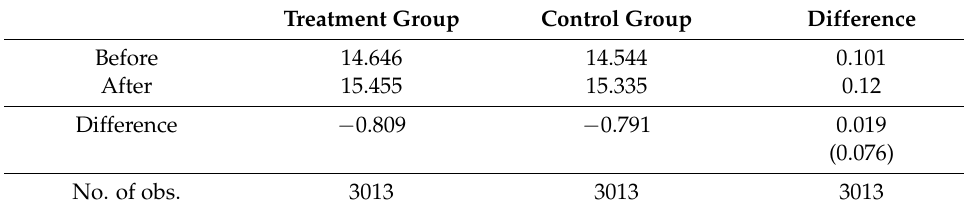
Table 4. The DID estimation of the impact of irrigation on log rice farm income. Treatment Group